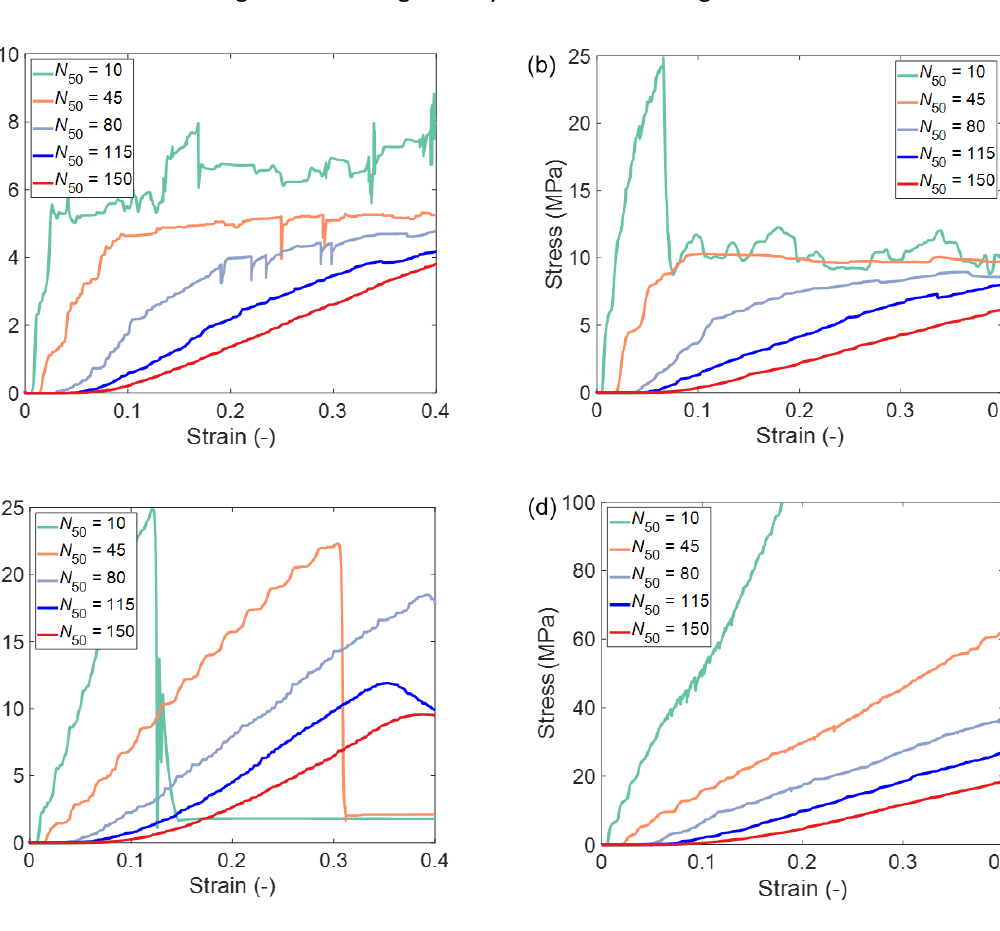
Fig. 6 Equivalent stress-strain relationships from numerical MTCT